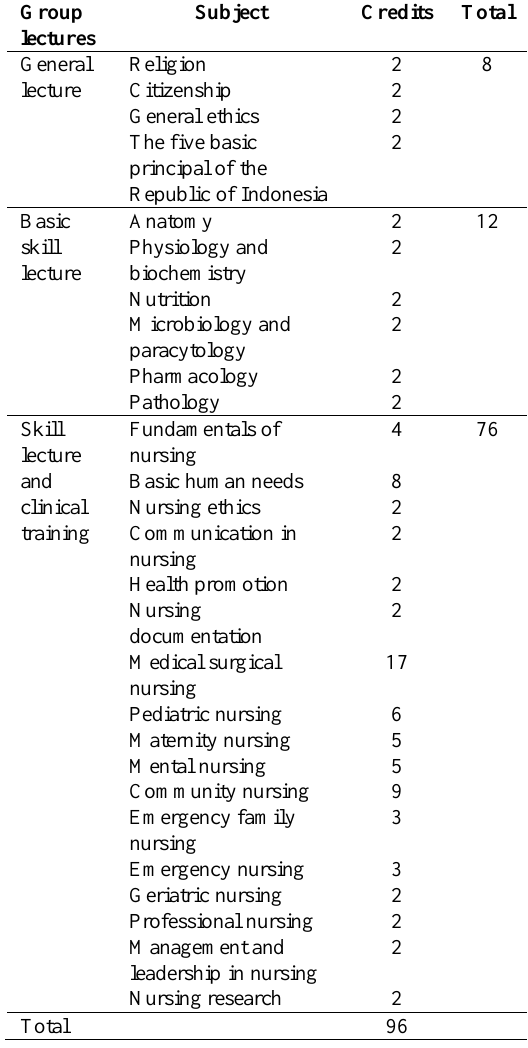
Table 1. Indonesian national curriculum